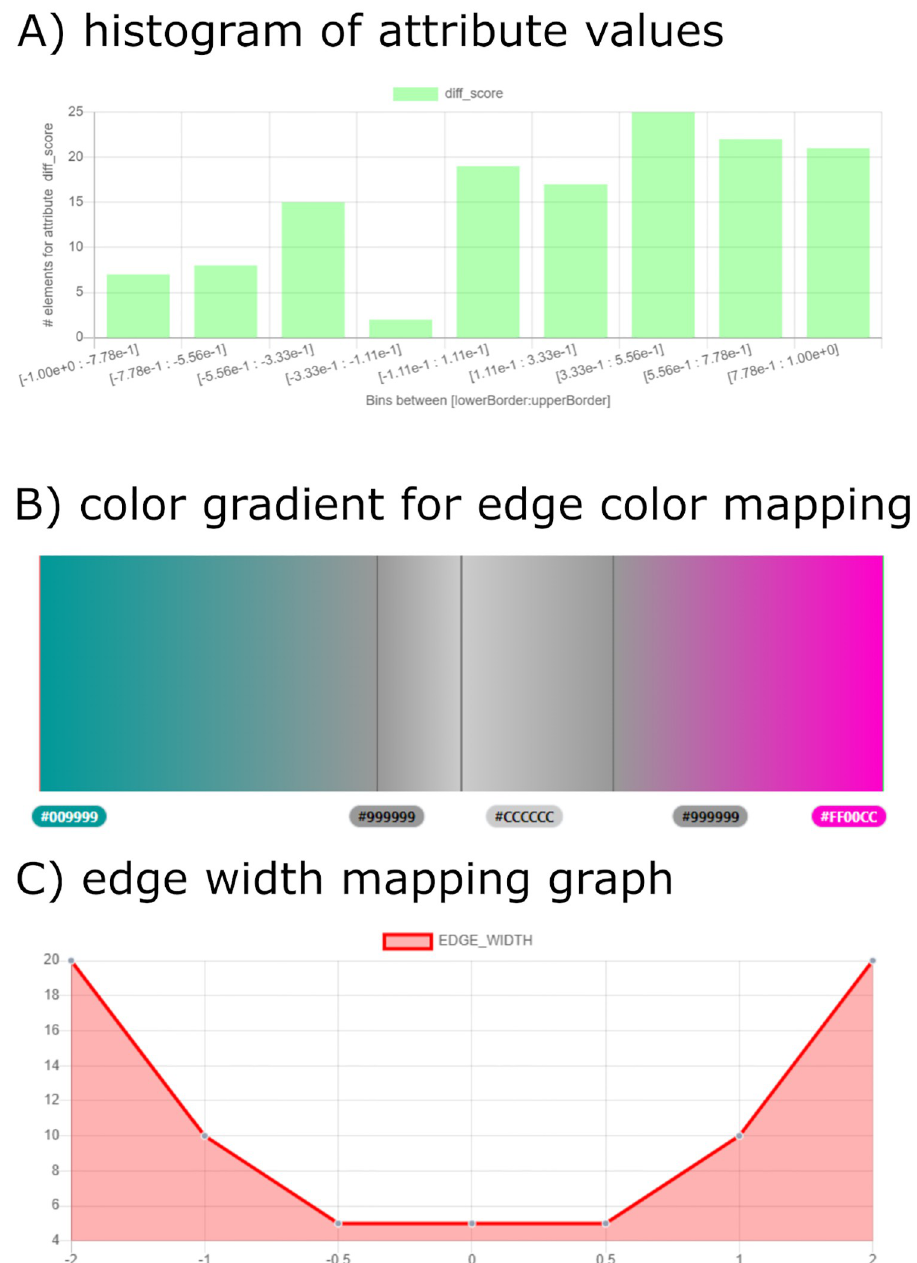
Fig 4. Continuous mapping of values of the edge attribute “diff_score”. A) Histogram for the “diff_score” attribute values. B) Continuous mapping of the values to a color gradient with marked boundary values. C) Mapping graph for “diff_score” values to edge